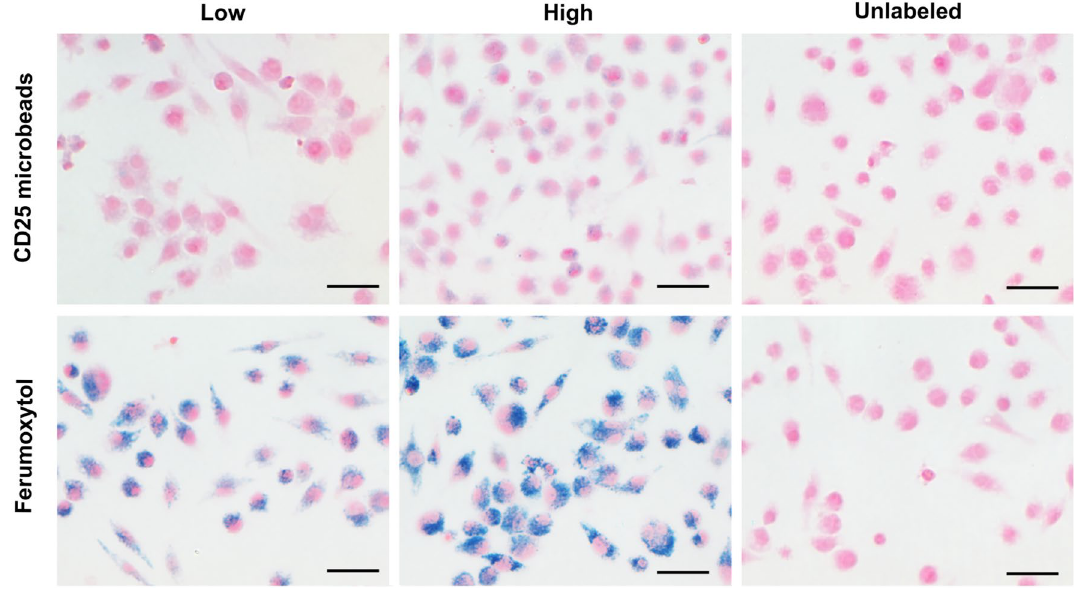
Figure 5. Histological assessment of nanoparticle uptake by macrophages. Light microscopy images of macrophages labeled with varying concentrations of CD25 microbeads (top row, low = 10 and high = 20 µl CD25 microbeads respectively) or ferumoxytol (bottom row, low = 200 and high = 400 µgFe/ml respectively) are displayed. Data shows strong intracellular localization of ferumoxytol (blue) , conversely to CD25 microbeads, suggesting that the CD25 antibody does not support internalization of the beads by unspecific phagocytic cells. Scale bar represents 100